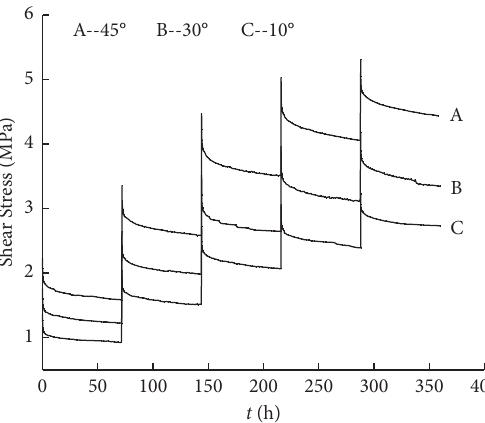
Figure 7: Relaxation curve of the entire process under step loading for σ � 3.924MPa.